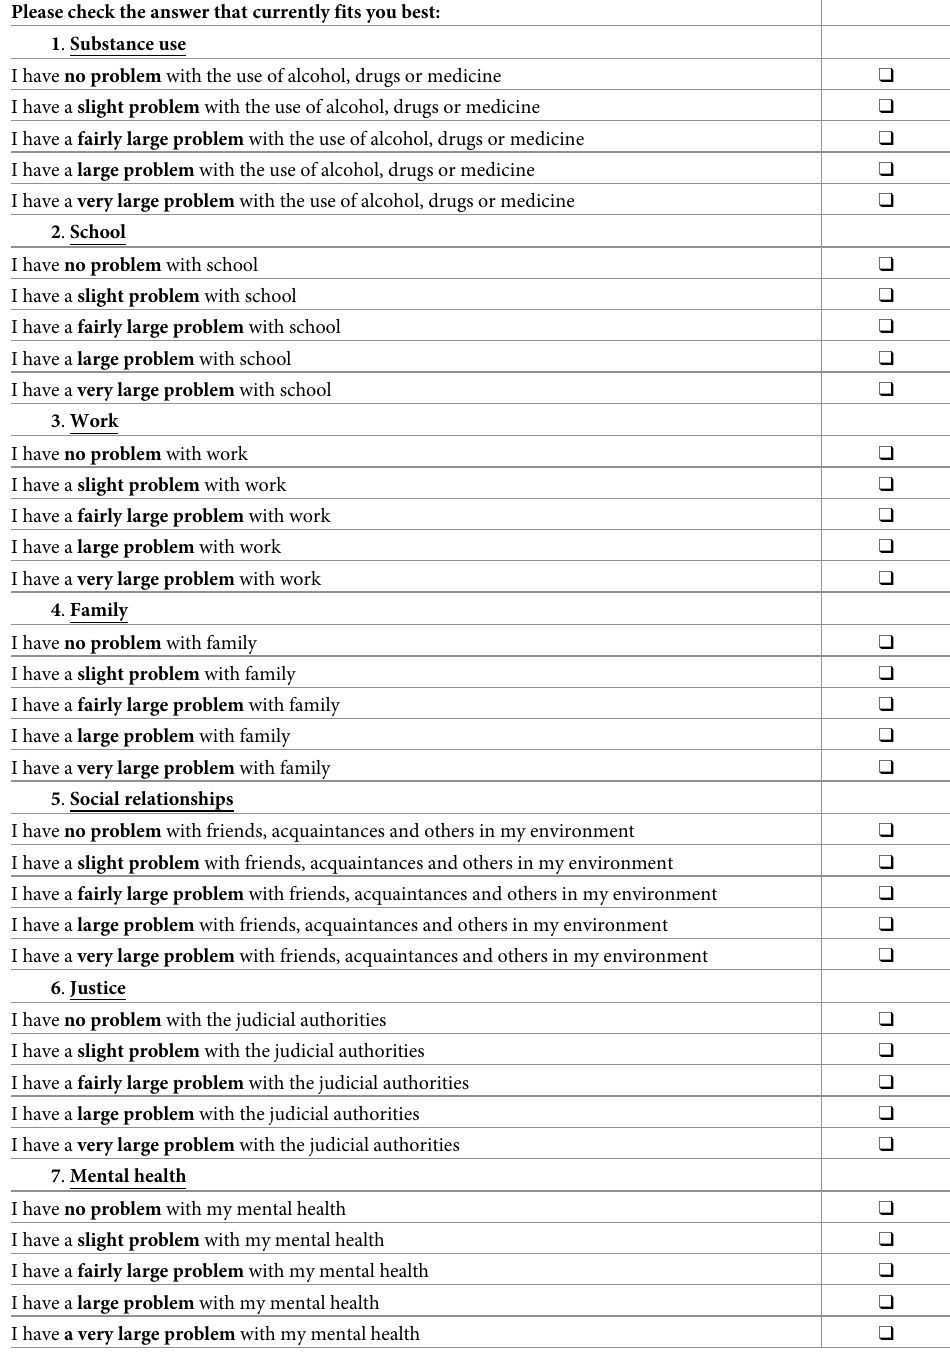
Table 1. Abbreviated self completion teen-addiction severity index (English version, B1 level). Please check the answer that currently fits you